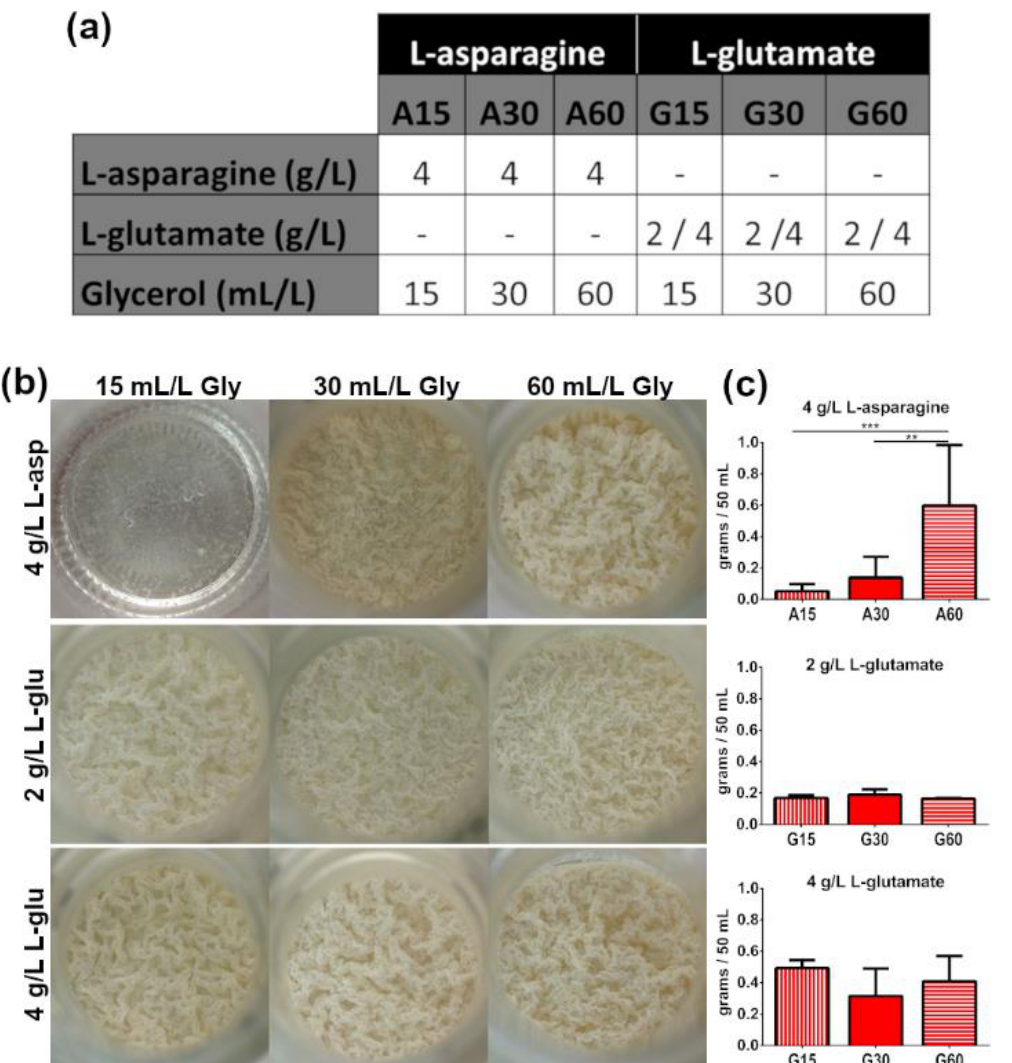
Figure 2. Influence of the amino acid source and glycerol concentration in Sauton medium on the growth of M. brumae in pellicles. ( a ) Formulation of the different Sauton media used in the study. L-glutamate was tested at two different concentrations (2 and 4 g/L); ( b ) macroscopic appearance; ( c ) biomass production of M. brumae pellicles grown in different amino acid sources and glycerol concentrations. Data represent the mean ± SD in each culture medium from at least three independent experiments. ** p < 0.001; *** p < 0.0001 (ANOVA test).